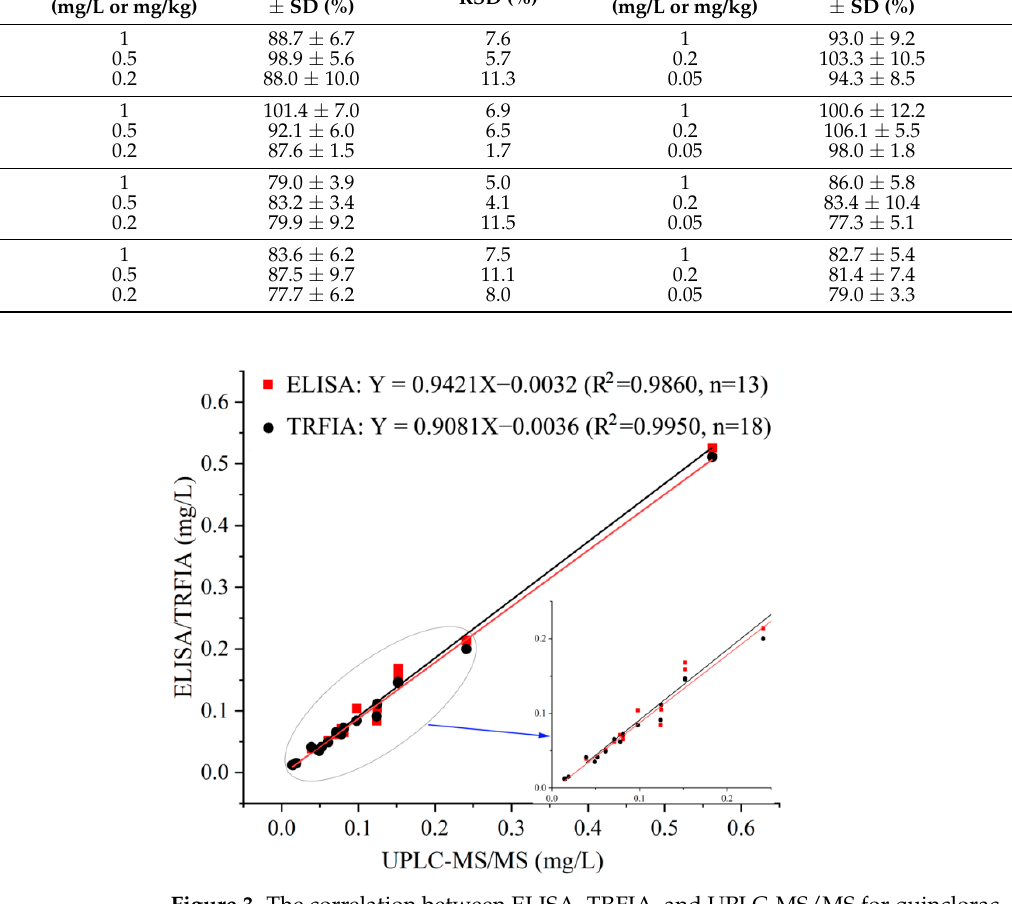
Figure 3. The correlation between ELISA, TRFIA, and UPLC-MS/MS for